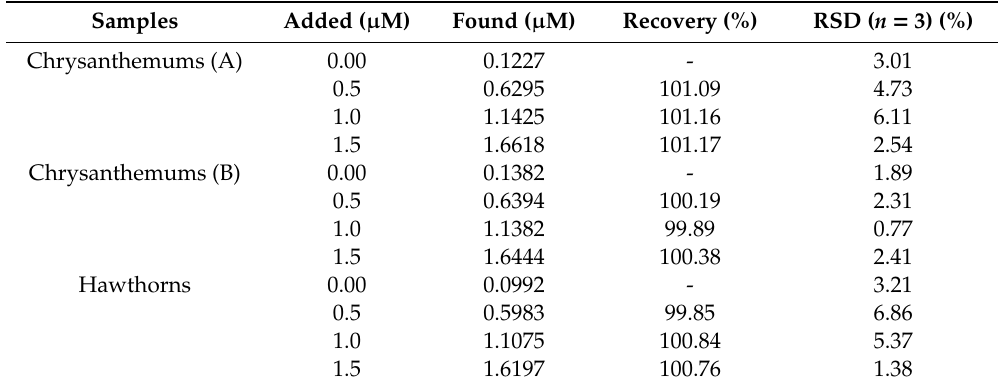
Table 2. Determination of LU concentration in real